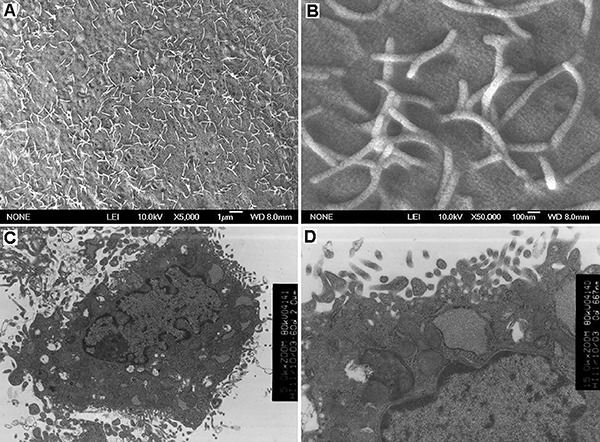
Ultrastructural characteristics of mouse intestinal epithelial cells (IECs). Scanning electron microscopy (SEM) showed that abundant microvilli were observed on the apical surface of the IECs (A, B). Transmission electron microscopy (TEM) of a cross-section demonstrated that IECs nucleus was large and irregular, showing large prominent nucleoli (C). TEM also revealed abundant microvilli on the surface of the cells (D).